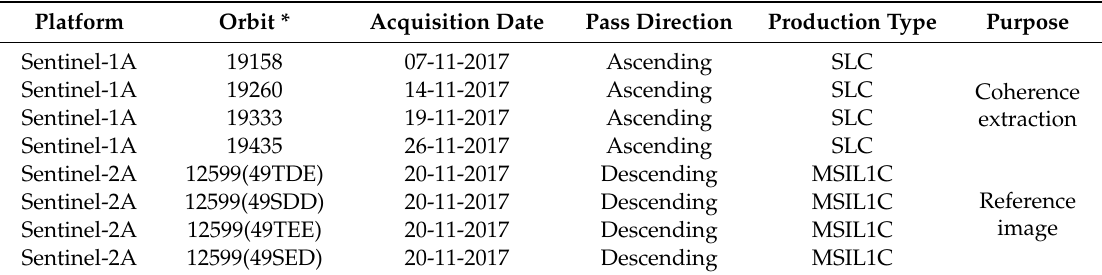
Table 1. SAR and multispectral imagery used in this